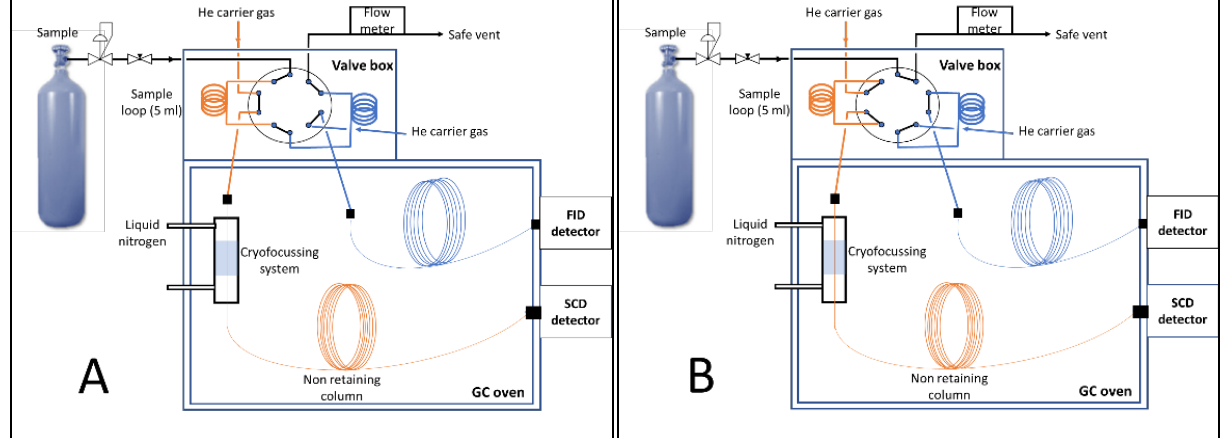
Figure 1. Schematic of the analytical technique. The cylinder sample is connected to the gas chro- matography system after an injection system composed of silconert-treated pressure regulator and needle valve. The gas chromatography system is connected to a 10-port valve. In ( A ), the sample gas is going through the 5 mL loop on the left of the valve box. In ( B ), the gas contained in the 5 mL sample loop is injected into a non-retaining column. The column is fitted into the cryo-focussing system and finally enters the sulphur chemiluminescence detector (SCD). The cryo-focussing system has a liquid-nitrogen-cooled system. Only a section of the column (blue section) is cooled to the set temperature of the method. The section on the right going into the FID detector was not used in this study.